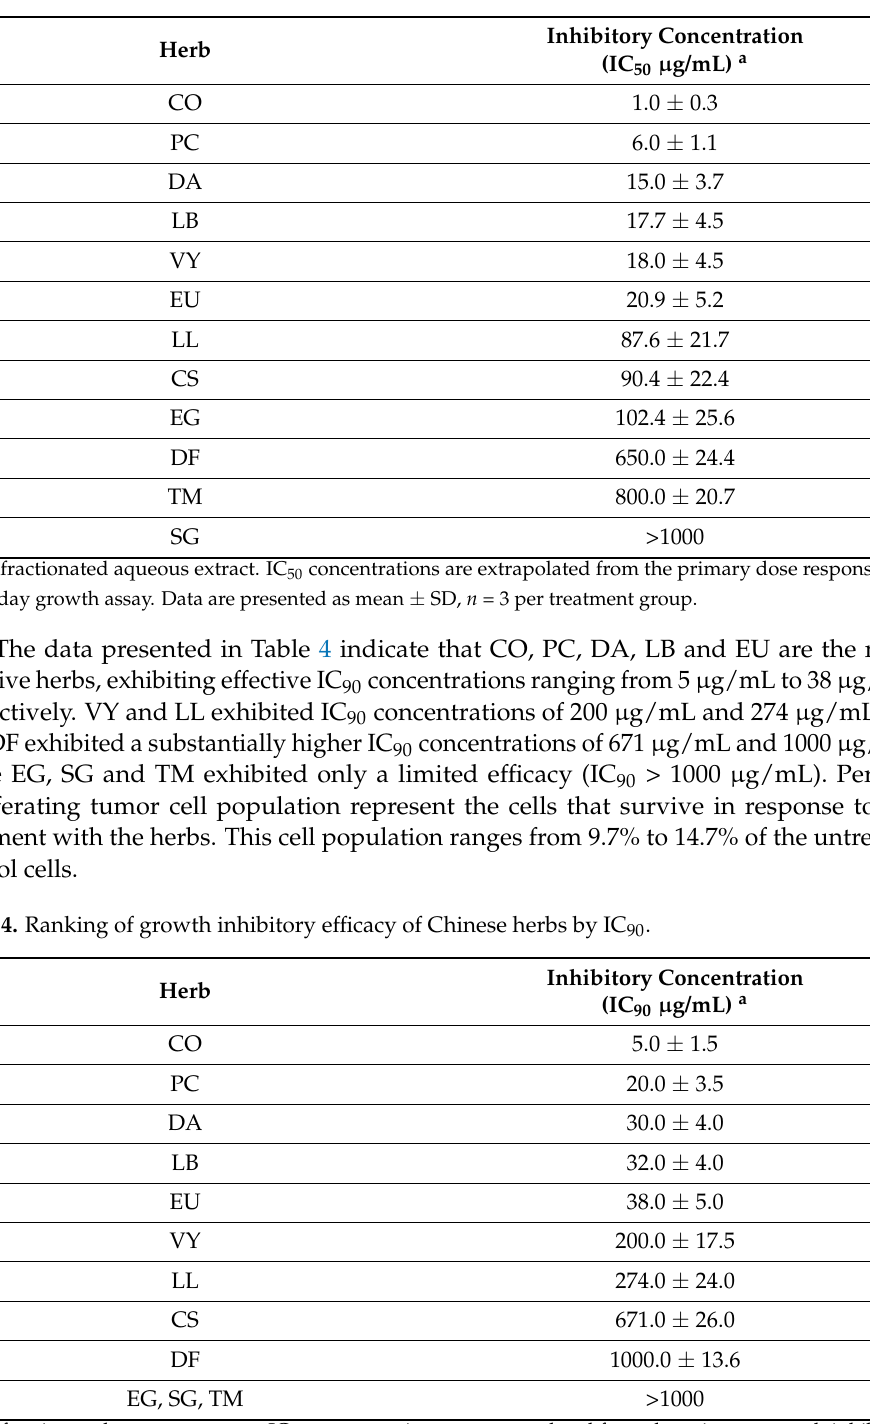
Table 3. Ranking of growth inhibitory efficacy of Chinese herbs by IC 50 .